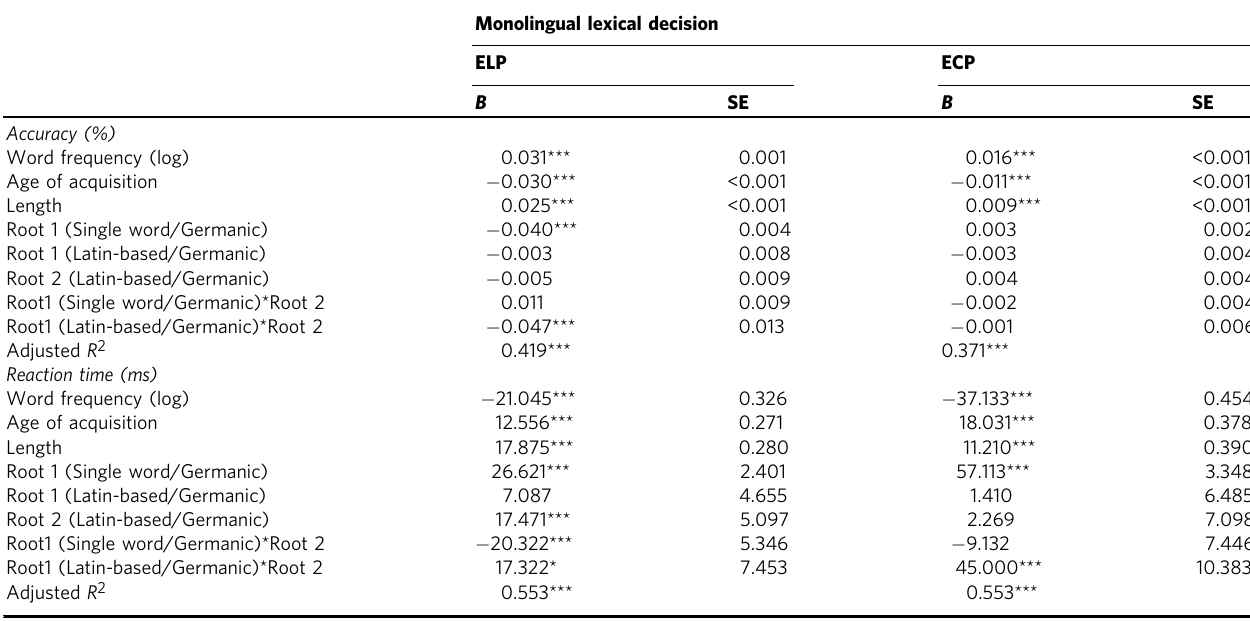
Table 4 English Lexicon Project and English Crowdsourcing Project: regression model results for lexical decision task (accuracy and reaction time).